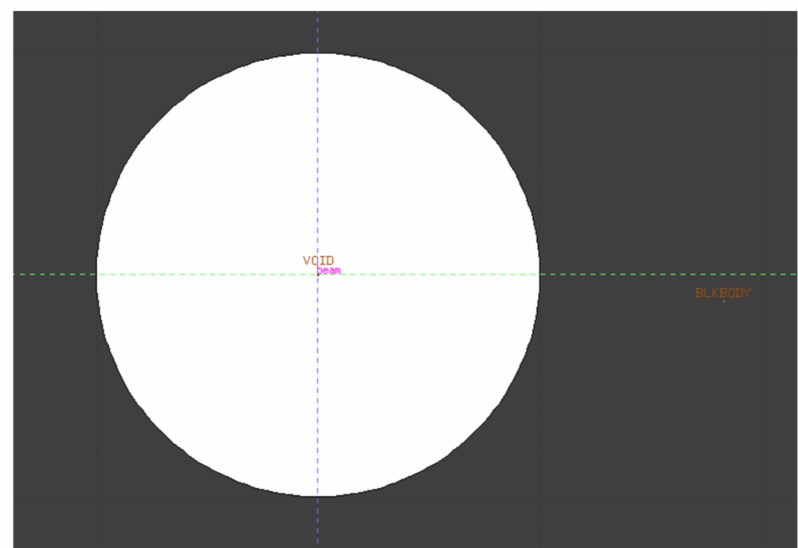
Figure 4. Geometry region modeling—target, void, black hole.